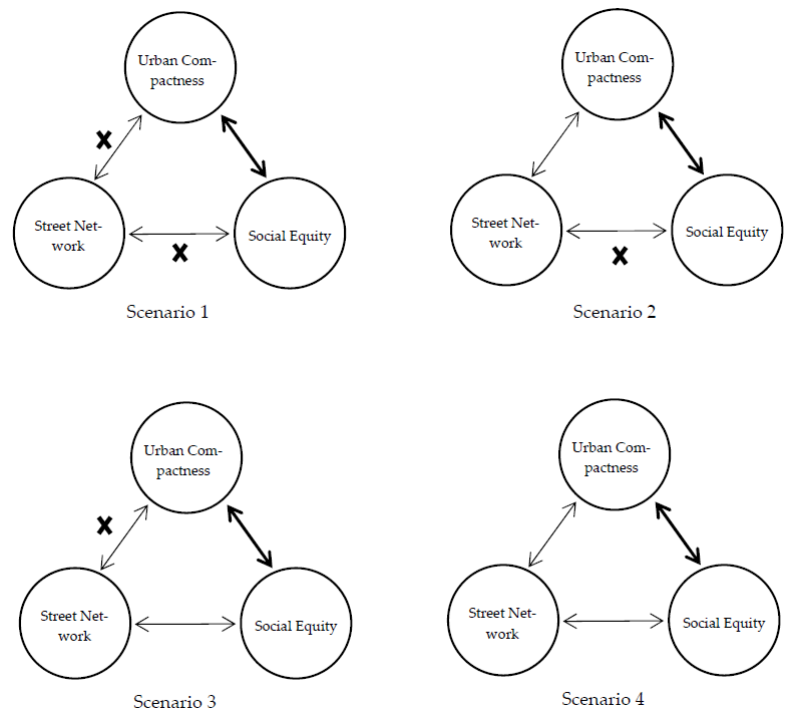
Figure 2. Different scenarios showing how topological accessibility, urban compactness, and social equity or inequity may be related to one another. Based on Burton’s findings, it is assumed that associations between urban compactness and social equity measures exist in all scenarios.